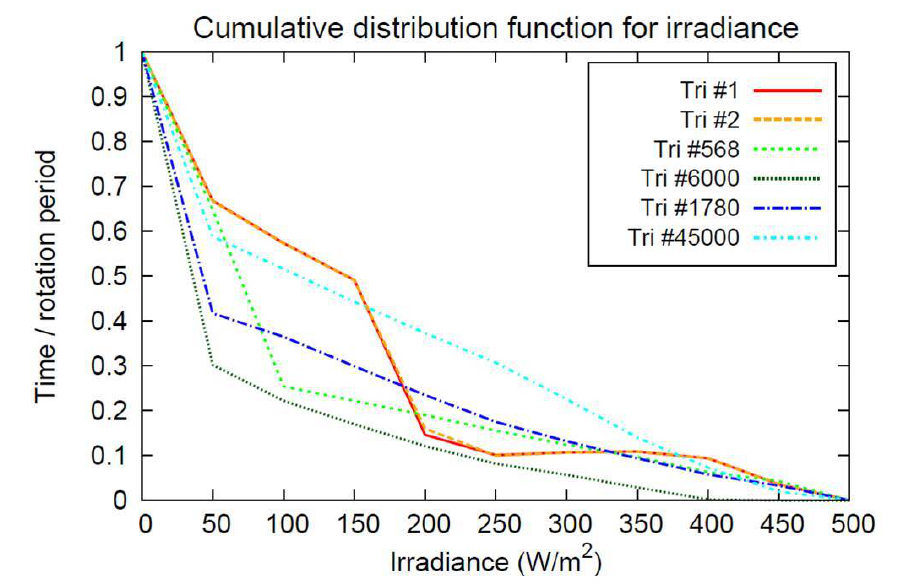
Figure 13. Cumulative distribution function for the irradiance at different points (triangle patches) on Phobos’ surface, relative to T tot being Phobos’ spin period, i.e., 7.65 h. F k ( x ) is shown, see Equation (14) for five different